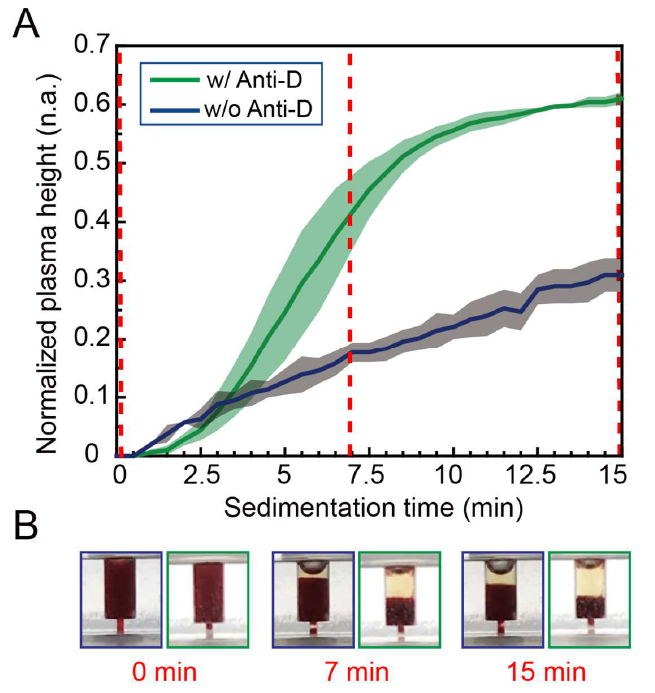
Figure 2. ( A ) The time-lapsed normalized plasma height and ( B ) a series of photos of blood sedimenta- tion in the blood containers with (green line) and without (blue line) anti-D treatment at 0, 7, and 15